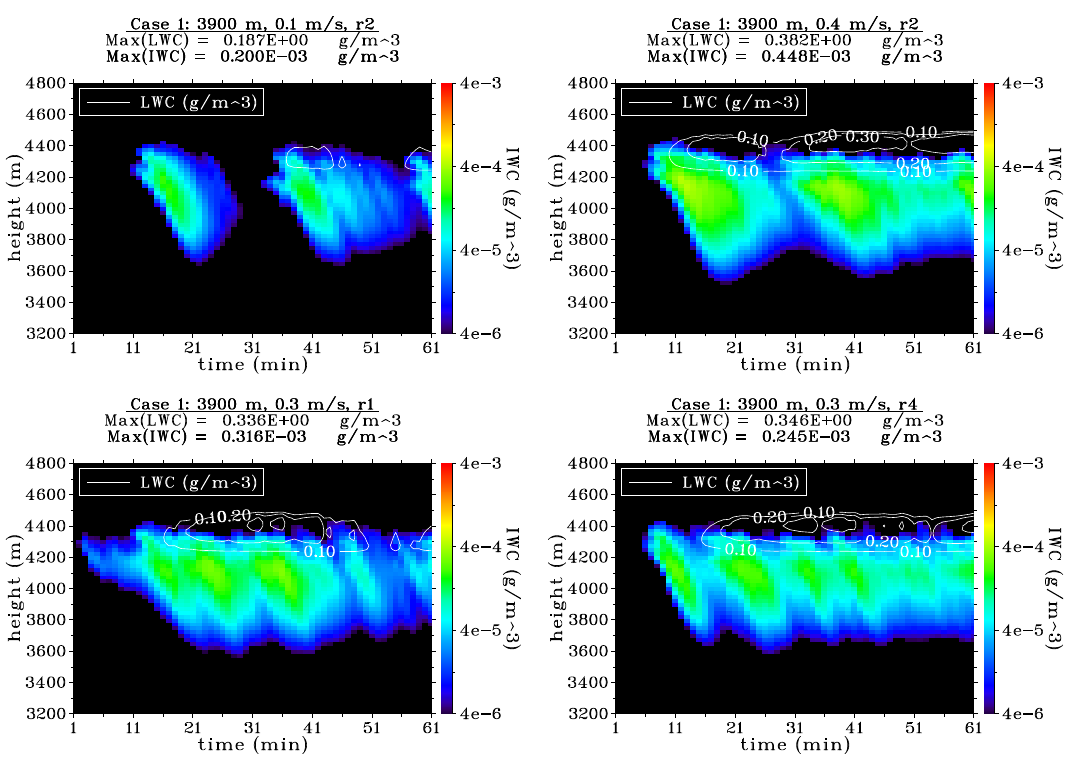
Figure 11. LWC (contours) and IWC (colors, logarithmic scale) for case 1. Comparison of different average updraft velocities w ave (upper panel: left: W_w01, w ave = 0 . 1ms − 1 ; right: W_w04, w ave = 0 . 4ms − 1 ) and different stochastic realizations (lower: left: W_r1, r1; right: W_r4, r4).